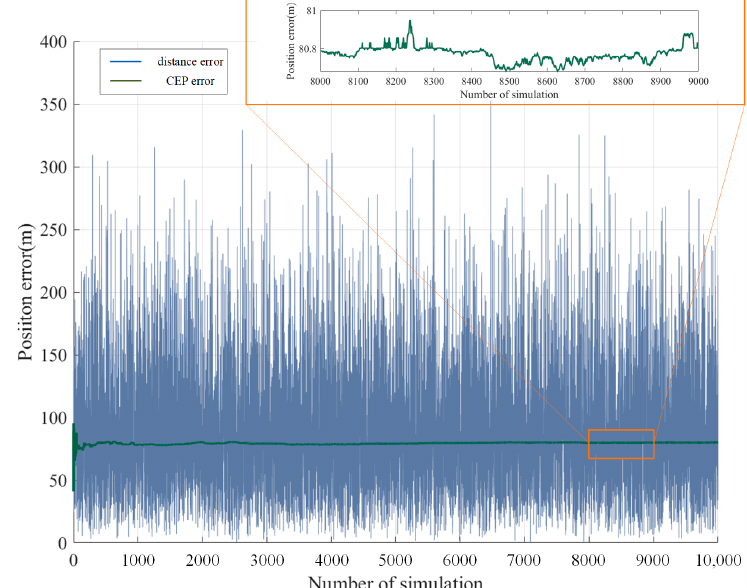
Remote Sens. 2023 , 15 , x FOR PEER REVIEW